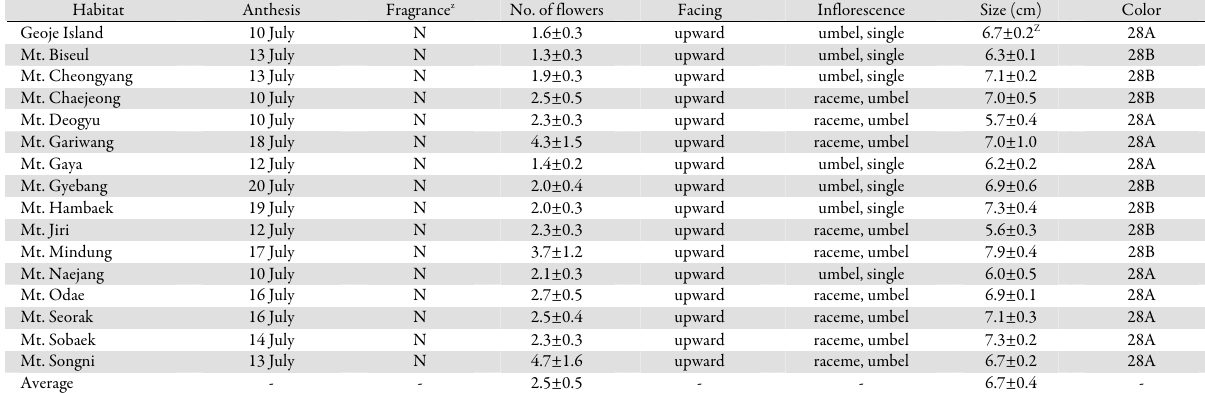
Tab. 1. Flowering seasonality, flower and inflorescence characteristics of L. tsingtauense by region in Korea (n=20) Habitat